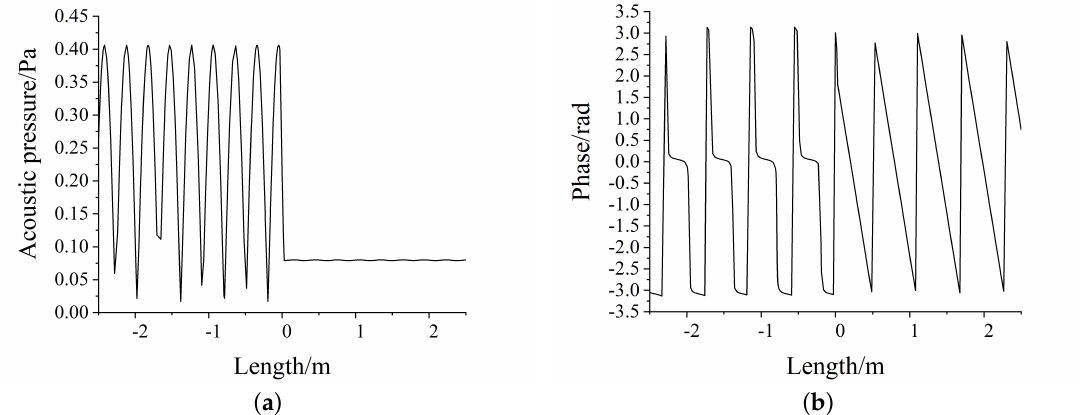
Figure 11. ( a ) The information of sound pressure amplitude in sound tube inner with steel sample at 2500 Hz. ( b ) The information of sound pressure phase in sound tube inner with steel sample at 2500